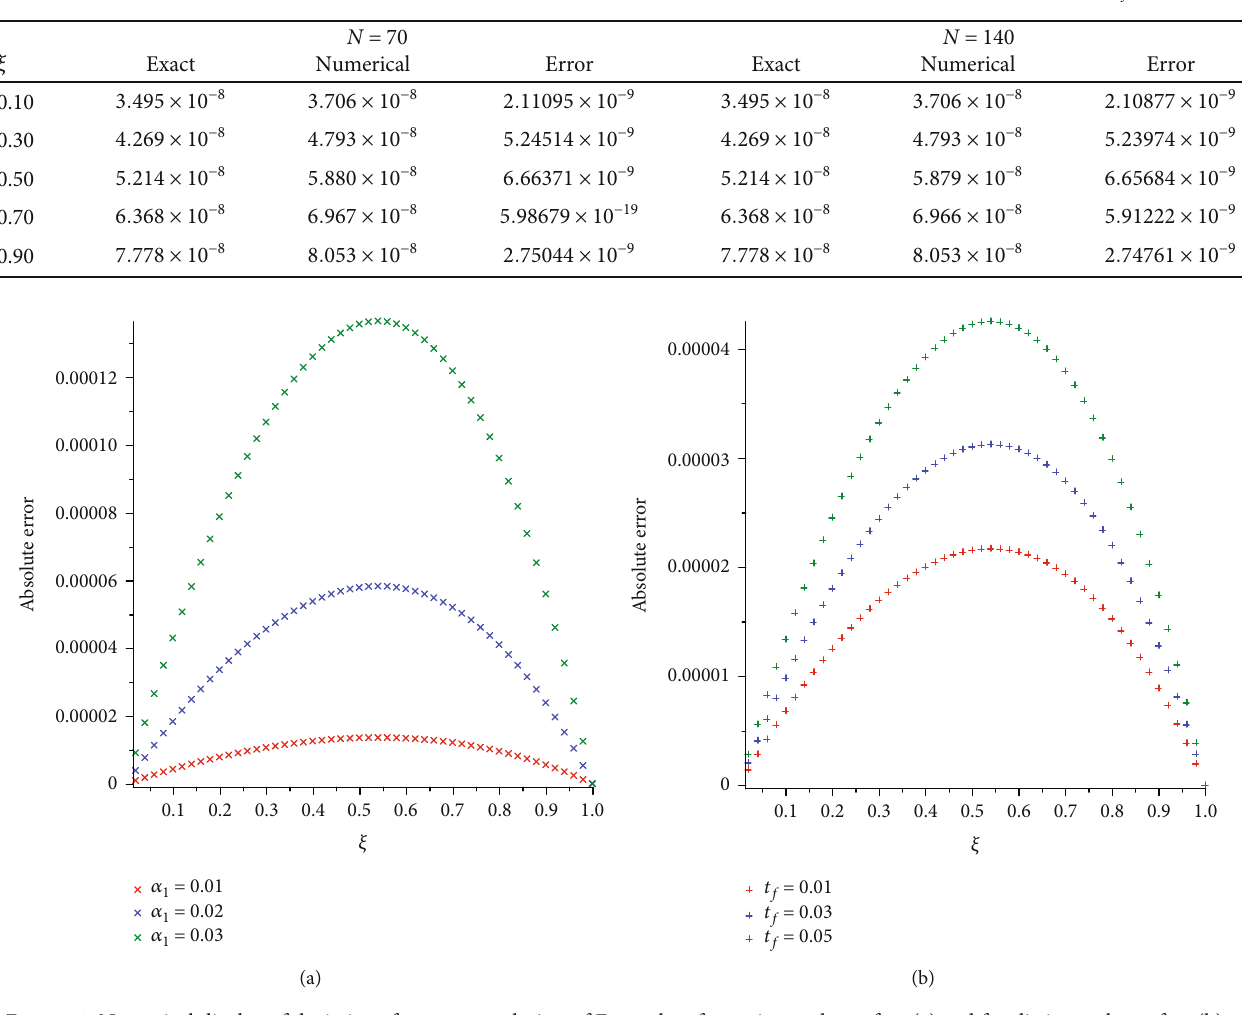
= 0 : 6 , α = 0 : 9 , and τ = 0 : 001 . 1 2 f